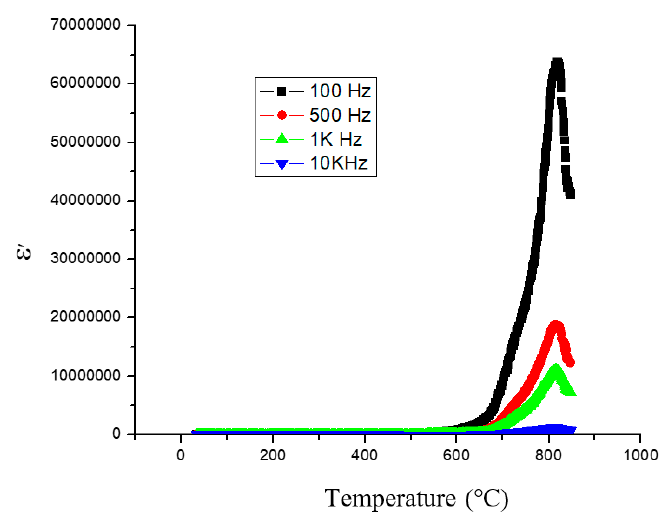
Figure 6. The e ff ect of temperature on the dielectric constant of BiFeO Figure 6. The effect of temperature on the dielectric constant of BiFeO 3. Figure 6. The effect of temperature on the dielectric constant of BiFeO 3.